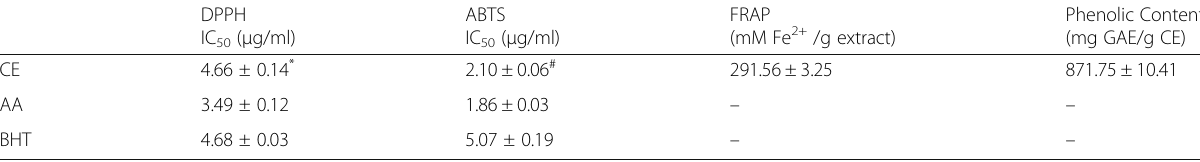
Table 2 Total phenolic content and antioxidant activities of C. cainito stem bark extract